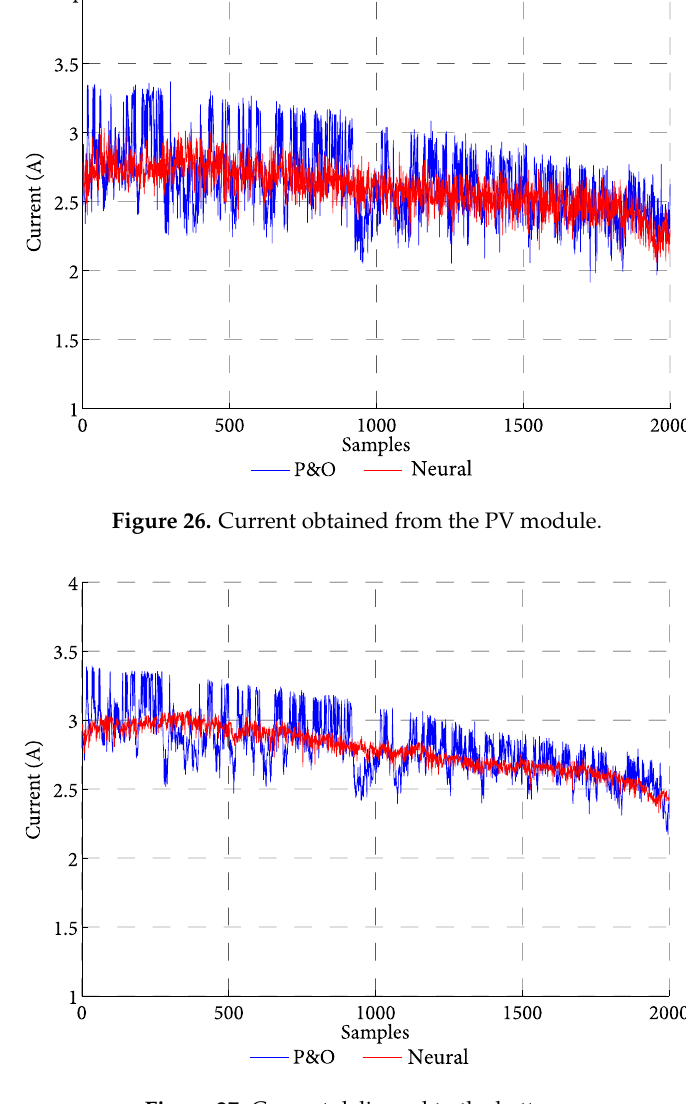
Figure 27. Current delivered to the battery.